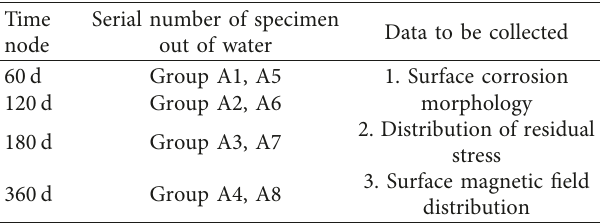
Table 4: Date when specimens go out of water and data